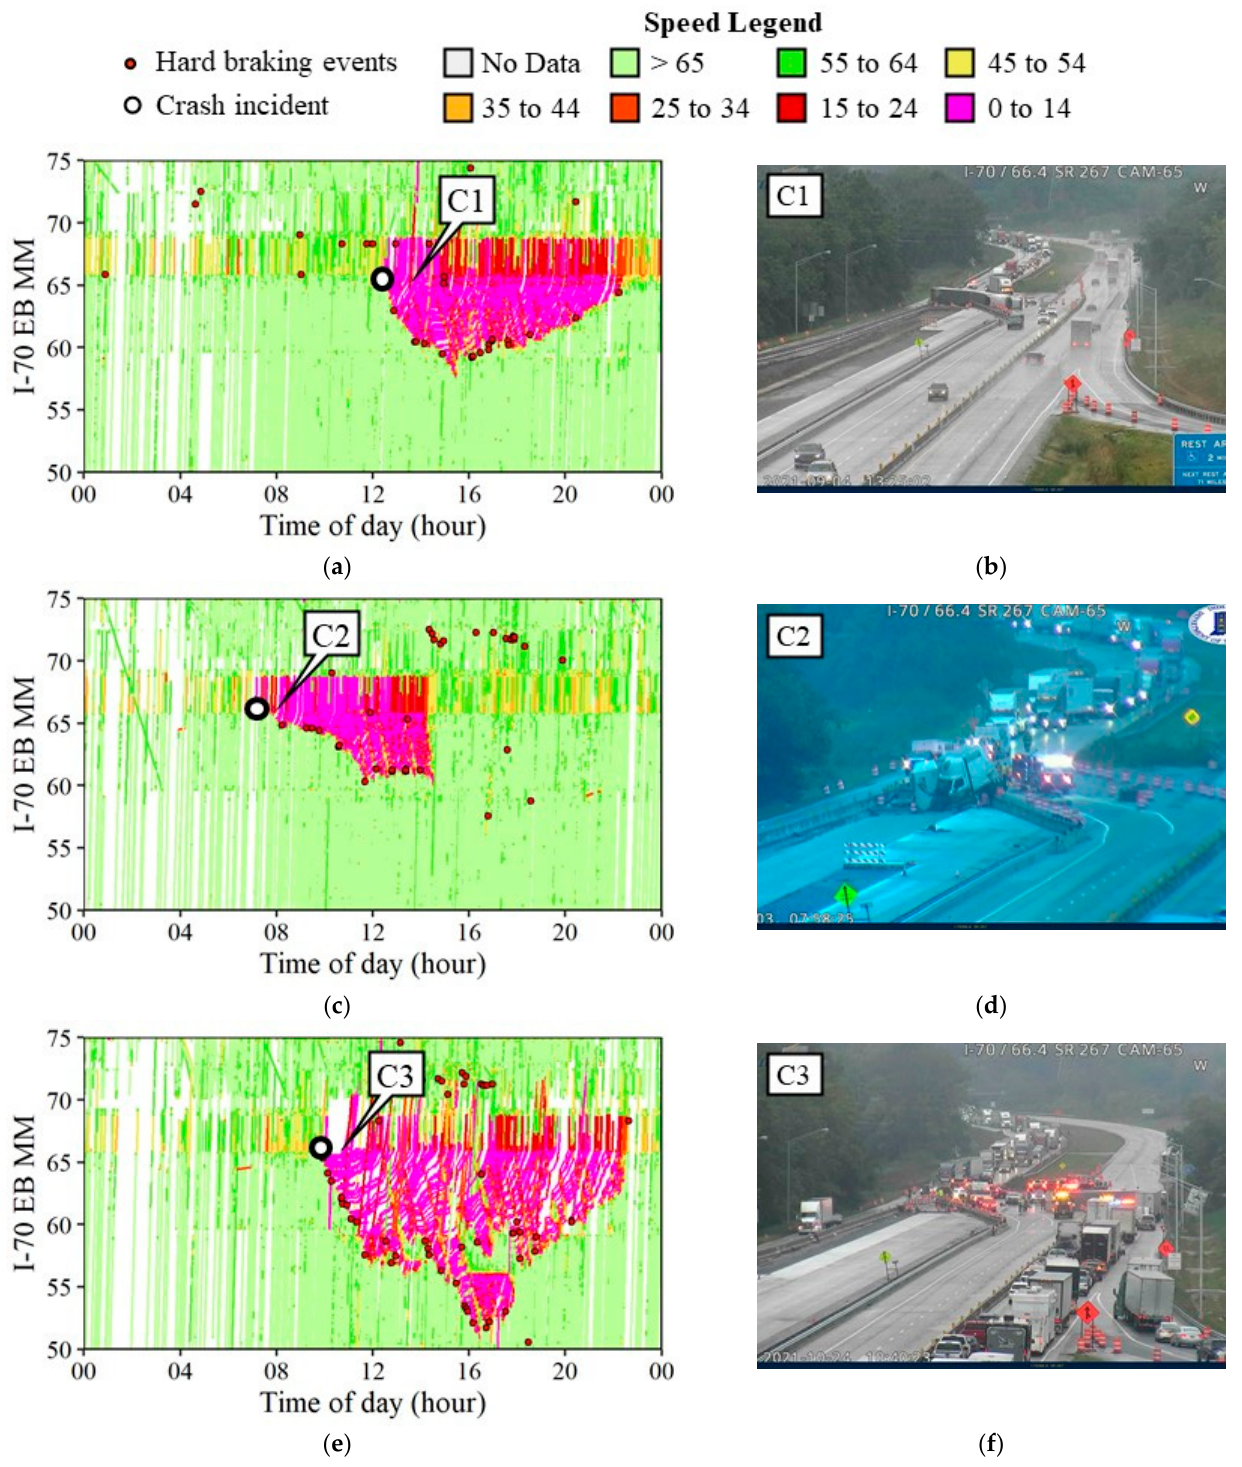
Figure 20. Traffic speed heatmaps and camera images on I-70 EB. ( a ) Saturday, 4 September 2021; ( b ) Camera image at 1:25 PM from MM 66.4; ( c ) Sunday, 3 October 2021; ( d ) Camera image at 7:58 AM from MM 66.4; ( e ) Sunday, 24 October 2021; ( f ) Camera image at 10:40 AM from MM 66.4.